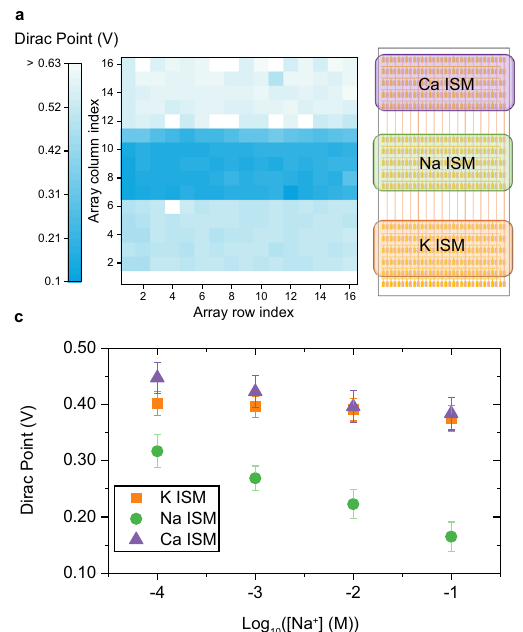
Fig. 3 | Highly integrated sensing chip with all three ISMs. a Schematic of the fullyintegratedionsensingchipwithallthreeISMs(right)andcorrespondingcolor mapshowing the DiracPoint of each sensing unit. The averageDiracPoint priorto functionalization is 0.15 ± 0.04V. White pixels indicate nonfunctional cells due to the fabrication process b I – V characteristics of devices on an integrated sensing chip measured in an electrolyte solution containing 100 μ M K + , 30mM Na + and 1mM Ca 2+ ions. The solid line is the average I – V characteristic and shaded region